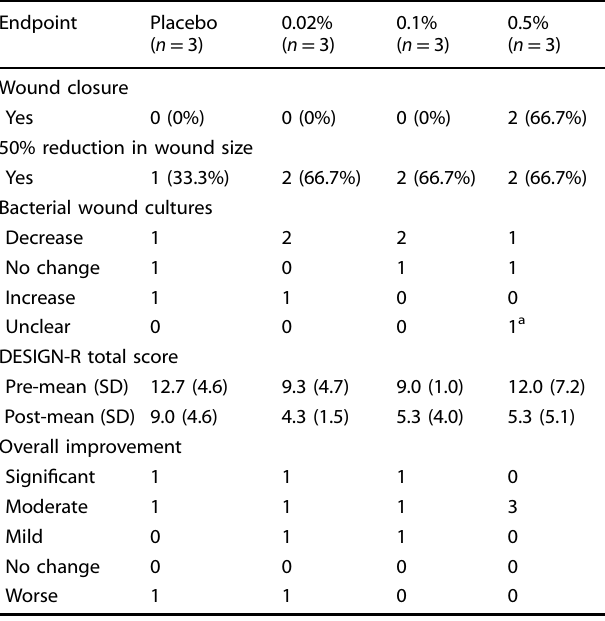
Table 3. Summary of secondary